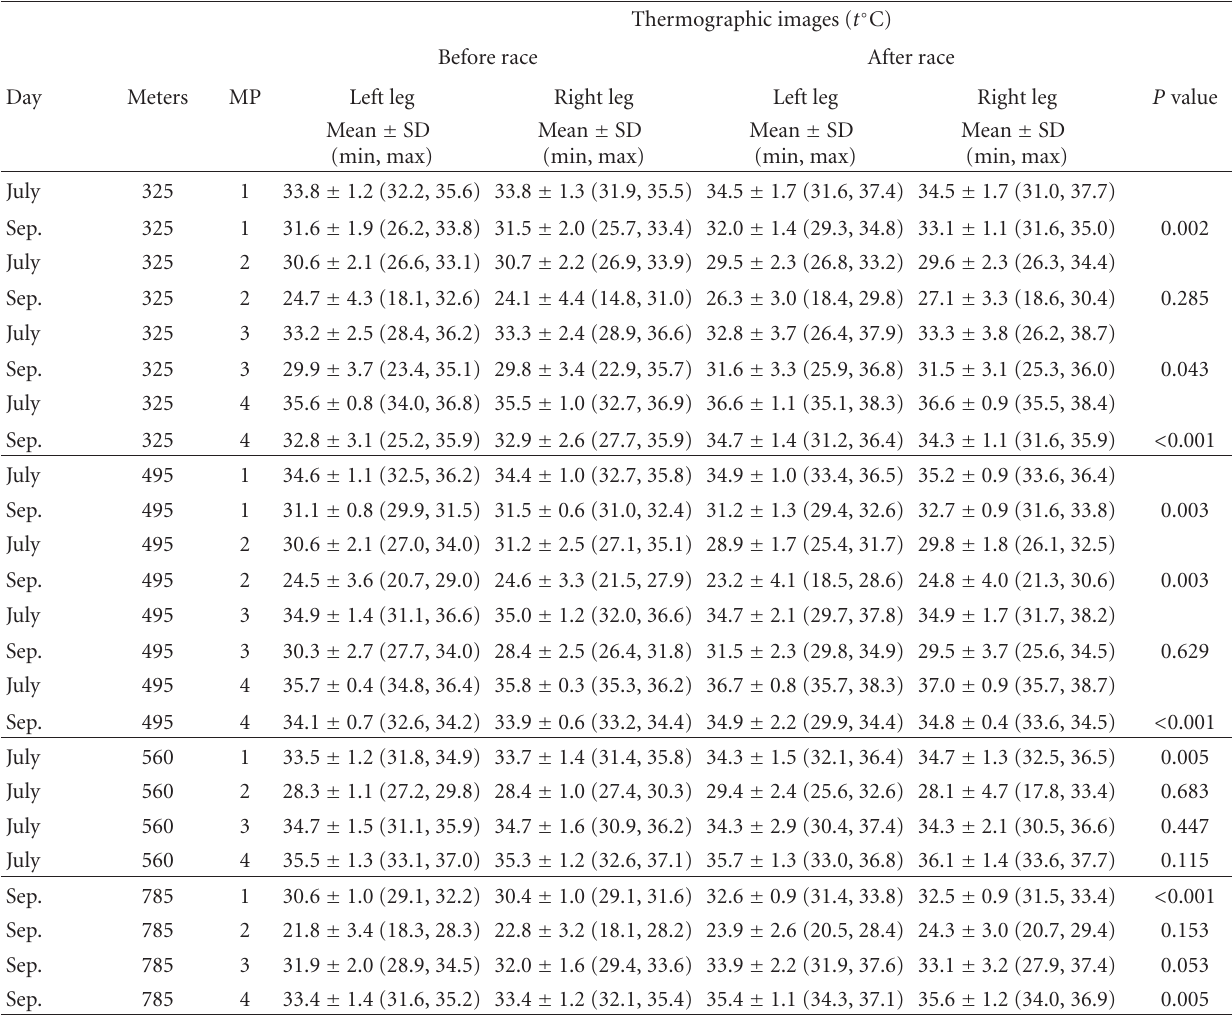
Table 1: Averages ± SD as well as minimum (min) and maximum (max) superficial temperatures obtained from the thermographic images. Measurement points (MPs) for the left and right leg: (1) musculus gastrocnemius, (2) tendo calcaneus, (3) musculus biceps femoris portio caudalis , and (4) musculus gracilis . P values are for di ff erences before and after the race for each measurement point and distance estimated from the primary statistical